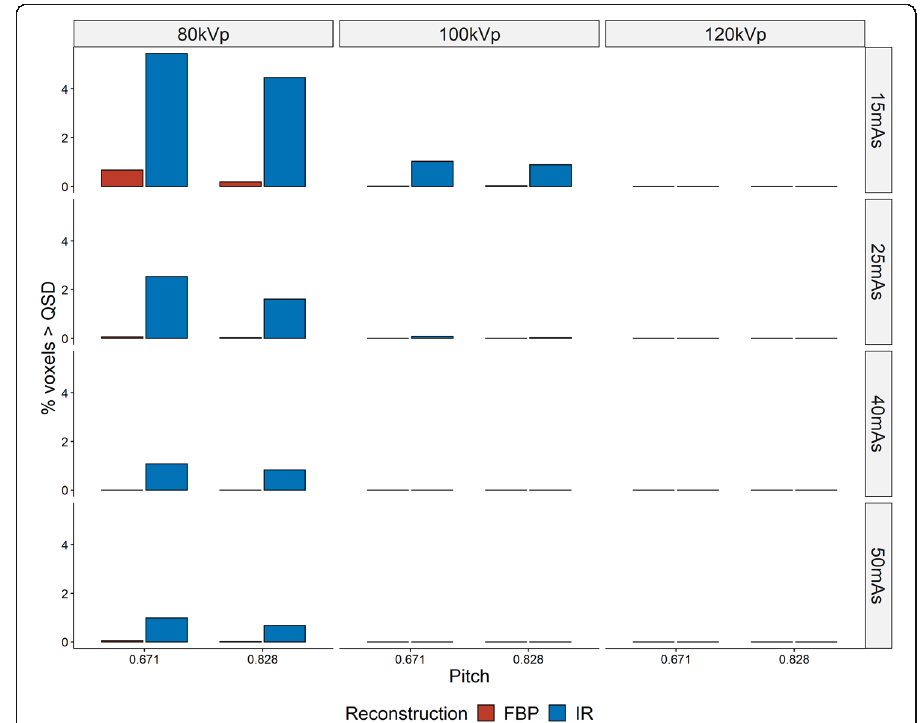
Fig. 5 Proportion of voxels in TRs that differed from the RR by greater than QSD